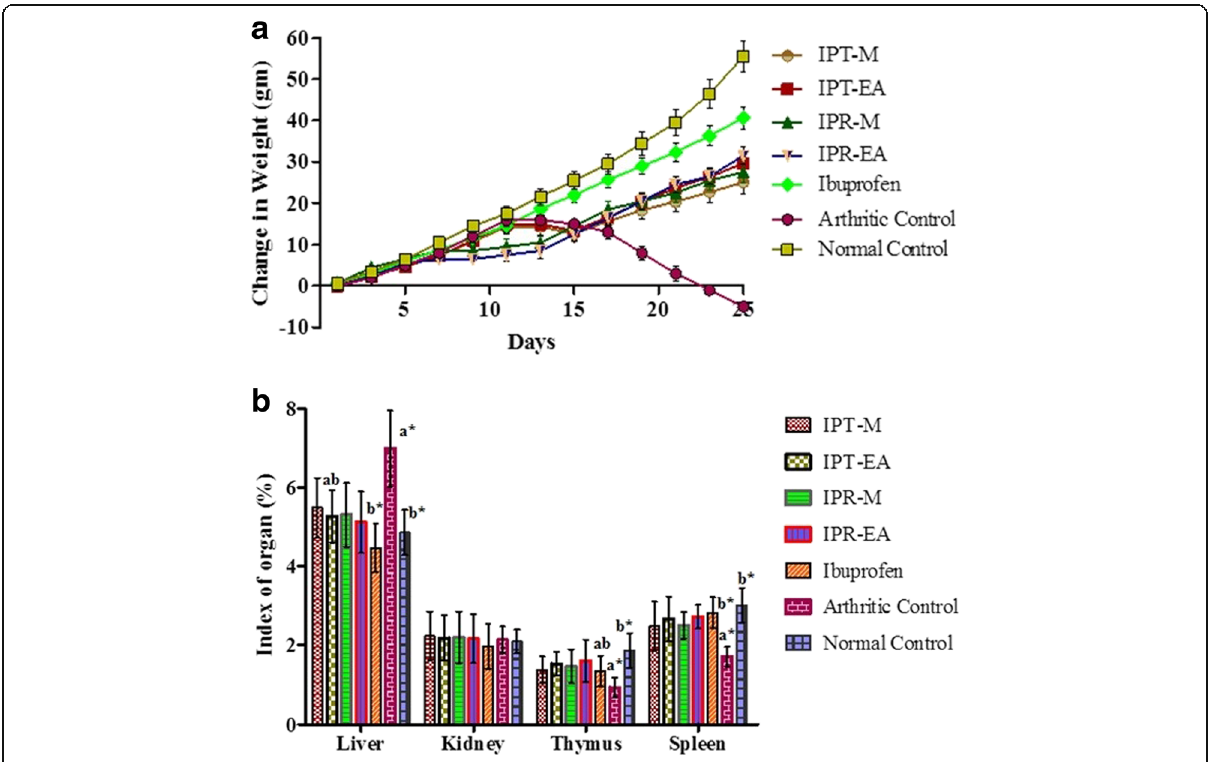
Fig. 6 Assessment of the change in body weight and organ index in experimental animals. a Variation in mean body weight over indicated period of time. b Normal and arthritic altered organs index. Each value represents the mean ± SD ( n = 6/group). Differences were considered significant at the level of * p <